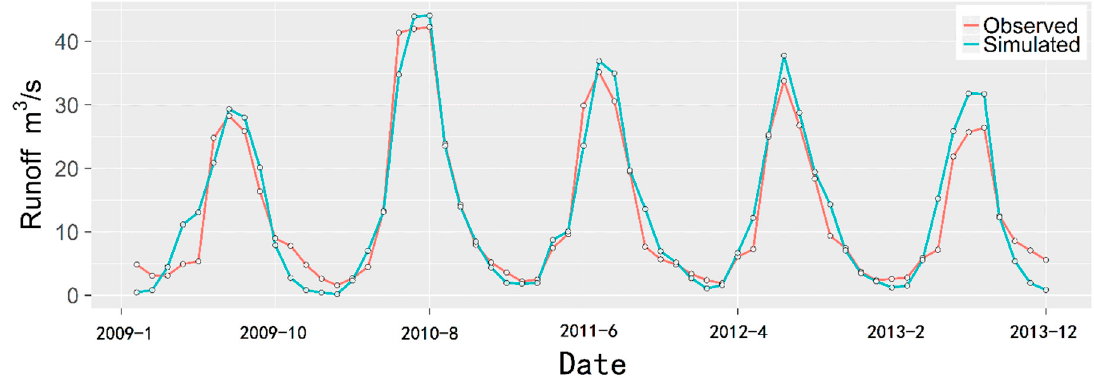
Figure 3. Monthly runoff (2009–2013) of Jinghe mountain station derived from the SWAT model driven by the CMADS.